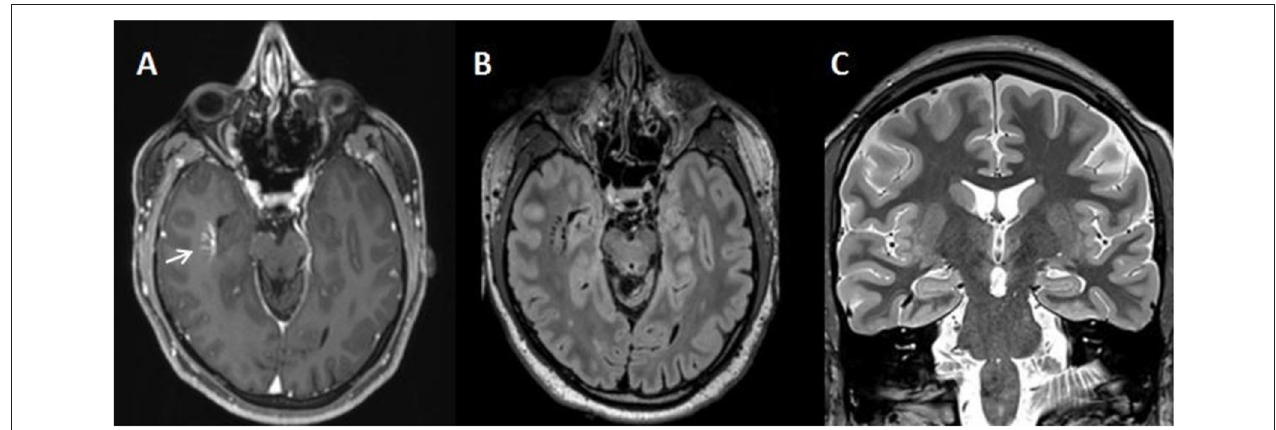
FIGURE 1 | Cerebral magnetic resonance imaging (cMRI) showing an isolated uncomplicated developmental venous anomaly in the right temporal lobe (white arrow) on the contrast enhanced initial axial MPRAGE (A) and on the 2 year follow-up epilepsy specific high-resolution T2-weighted axial reformatted 3D-FLAIR (B) and coronal T2-weighted STIR (C) images. cMRI scans were acquired on a Siemens 3T scanner TRIO (A) and PRISMA (B,C)